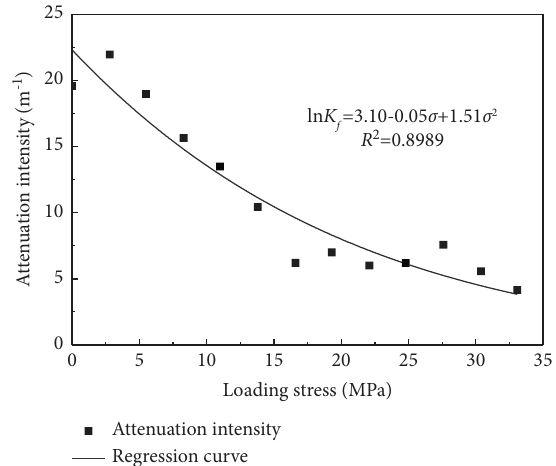
Figure 11: Relation between attenuation intensity and loading stress.